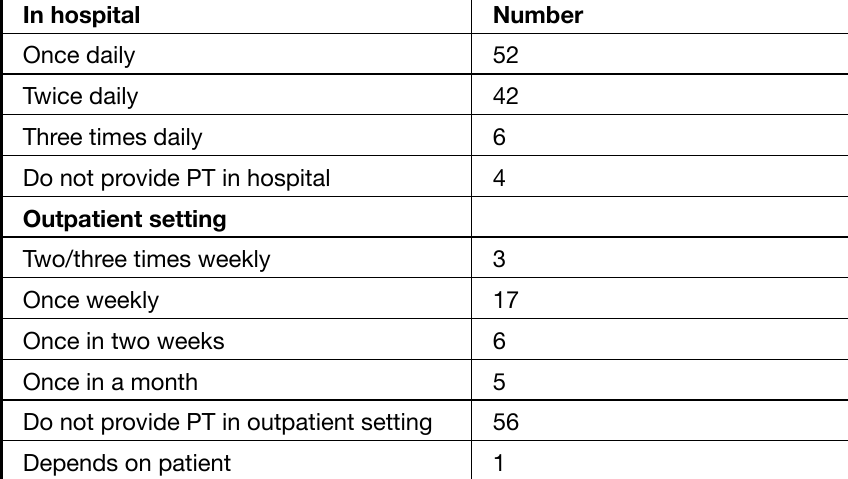
Table 1: Frequency of physiotherapy interventions in hospital